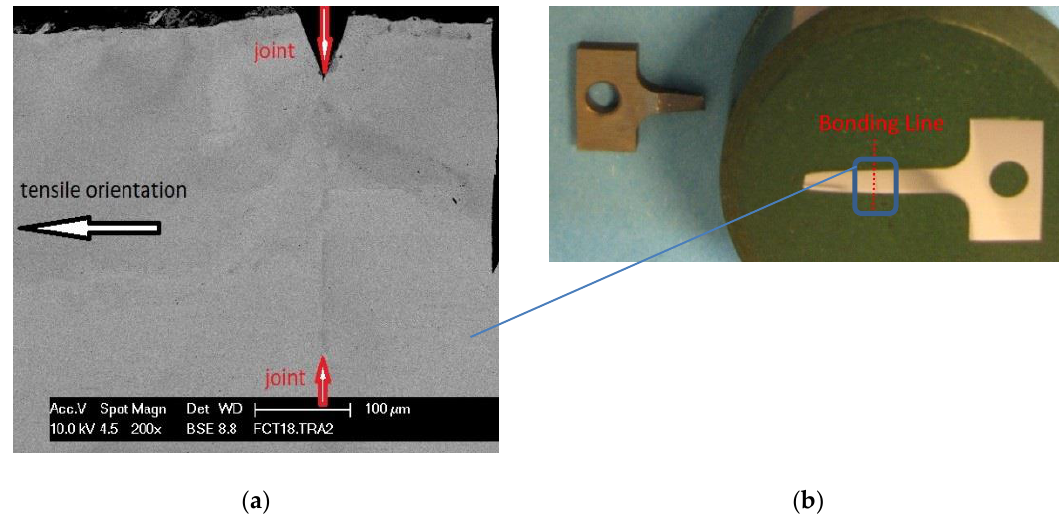
Figure 12. ( a ) Micrograph obtained by SEM of the bonding interface of a flat specimen from Sample 4 tested at 750 °C, ( b ) Location of the assembly area on the tensile specimen which is observed by SEM. ◦ ◦ Nevertheless, the tensile tests conducted at 20 C and 750 C indicate that this joint achieved an interesting value of maximum strength. This study clearly demonstrates the potential to join ODS PM2000 steel to itself using a SPS